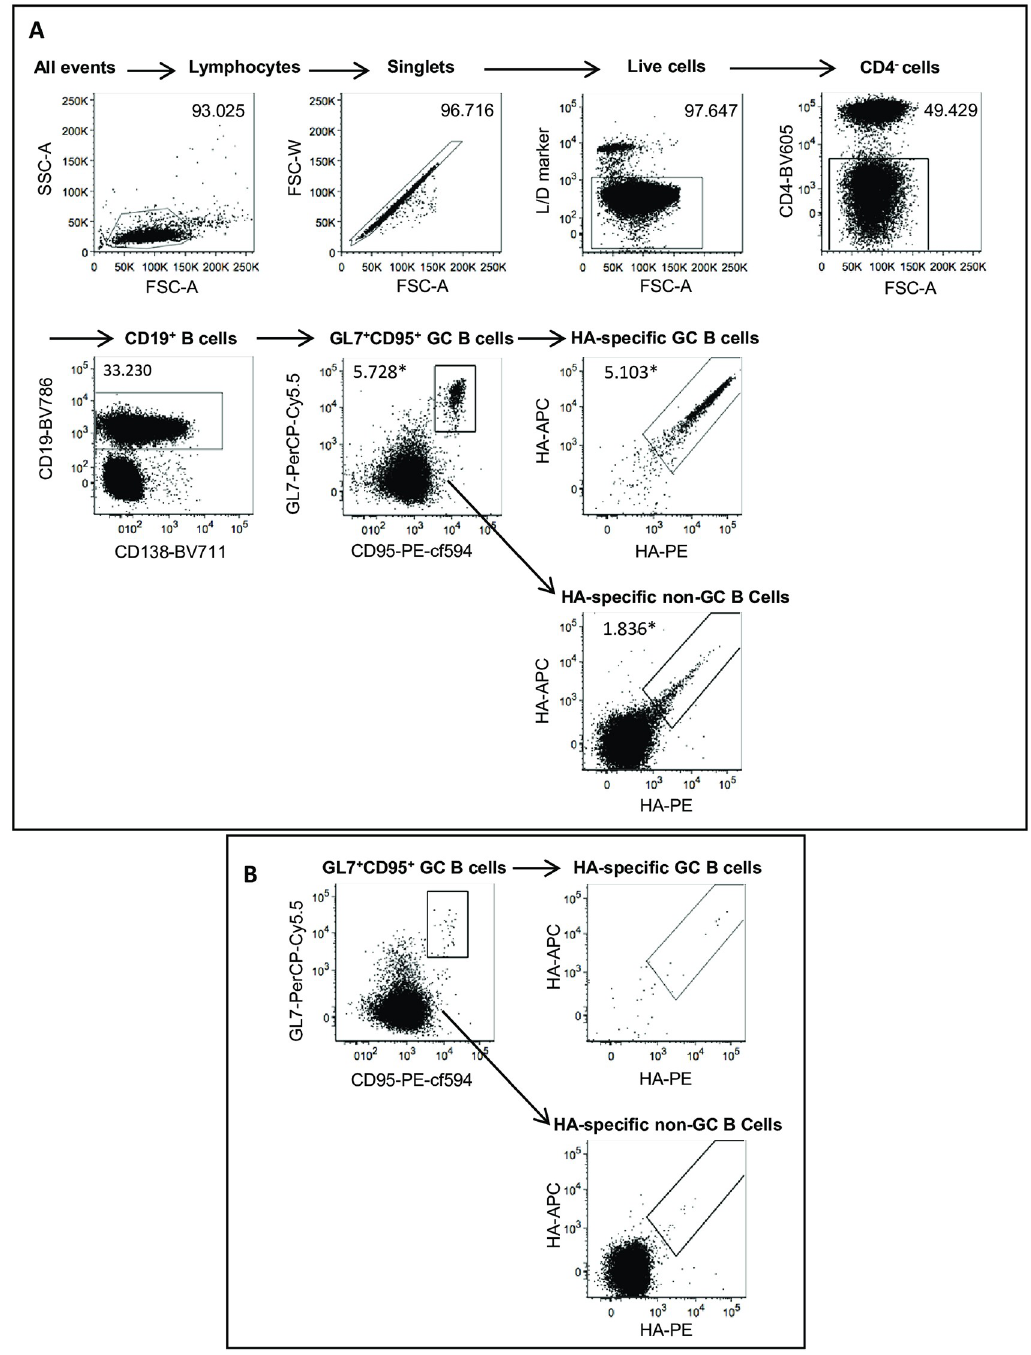
Fig 1. The applied flowcytometric B-cell phenotyping panel is able to identify HA specificity within B-cell subsets. Mouse iliac lymph node cells were obtained 19 days post-prime immunization with alum adjuvanted FL H1#2316 (A) or PBS (B). Cells were subsequently stained for CD4, CD19, CD138, GL7, CD95, and a biotinylated HA probe (FL H1#5070) conjugated to APC (HA-APC) and PE (HA-PE) fluorochromes was used to assess HA binding among B cell subsets. Gate frequencies are indicated as frequency of parent or, if followed by a “ � ”, as frequency of CD19+ B-cells. Arrows drawn from gates to plots show the applied sequential gating steps to identify the cell populations shown in plot titles in (B) all gating steps prior to the identification of B cells are not shown. Data are representative for n = 8 immunized